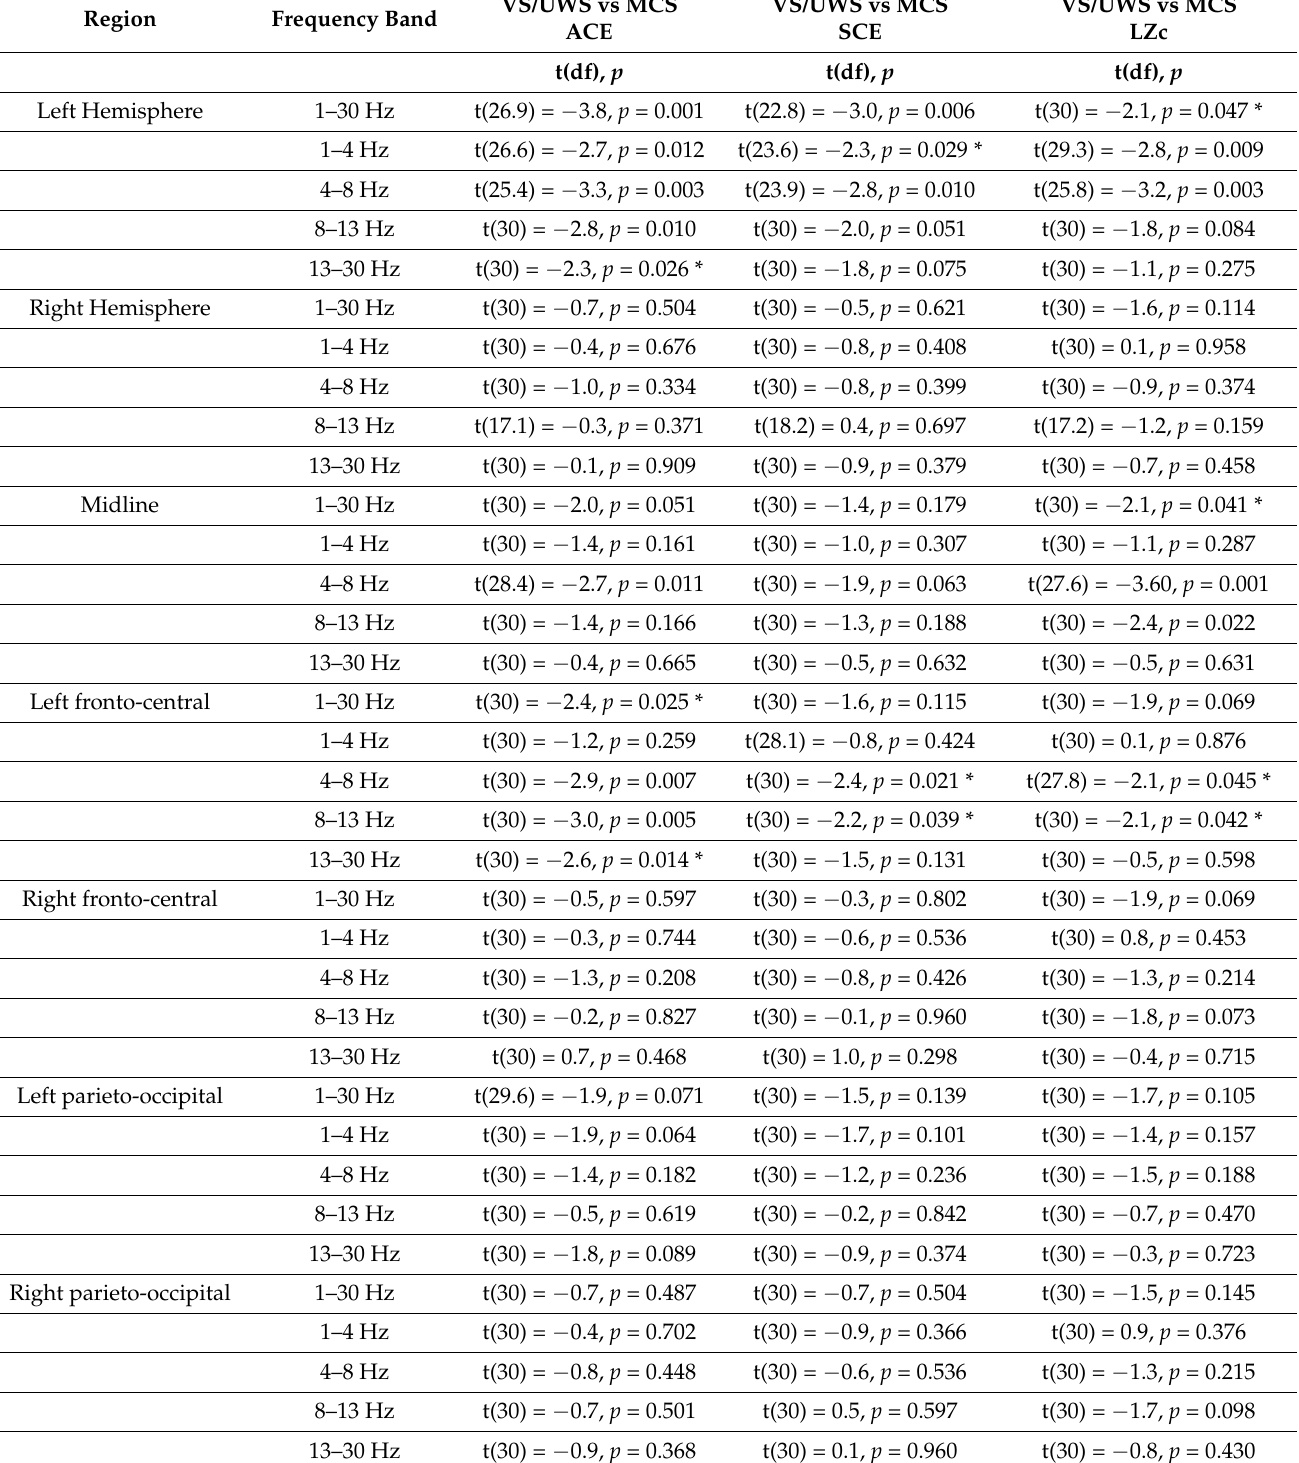
Table 1. Post hoc comparison of entropy measures assessed in MCS vs. VS/UWS patients in different regions (*) indicates value not surviving FDR